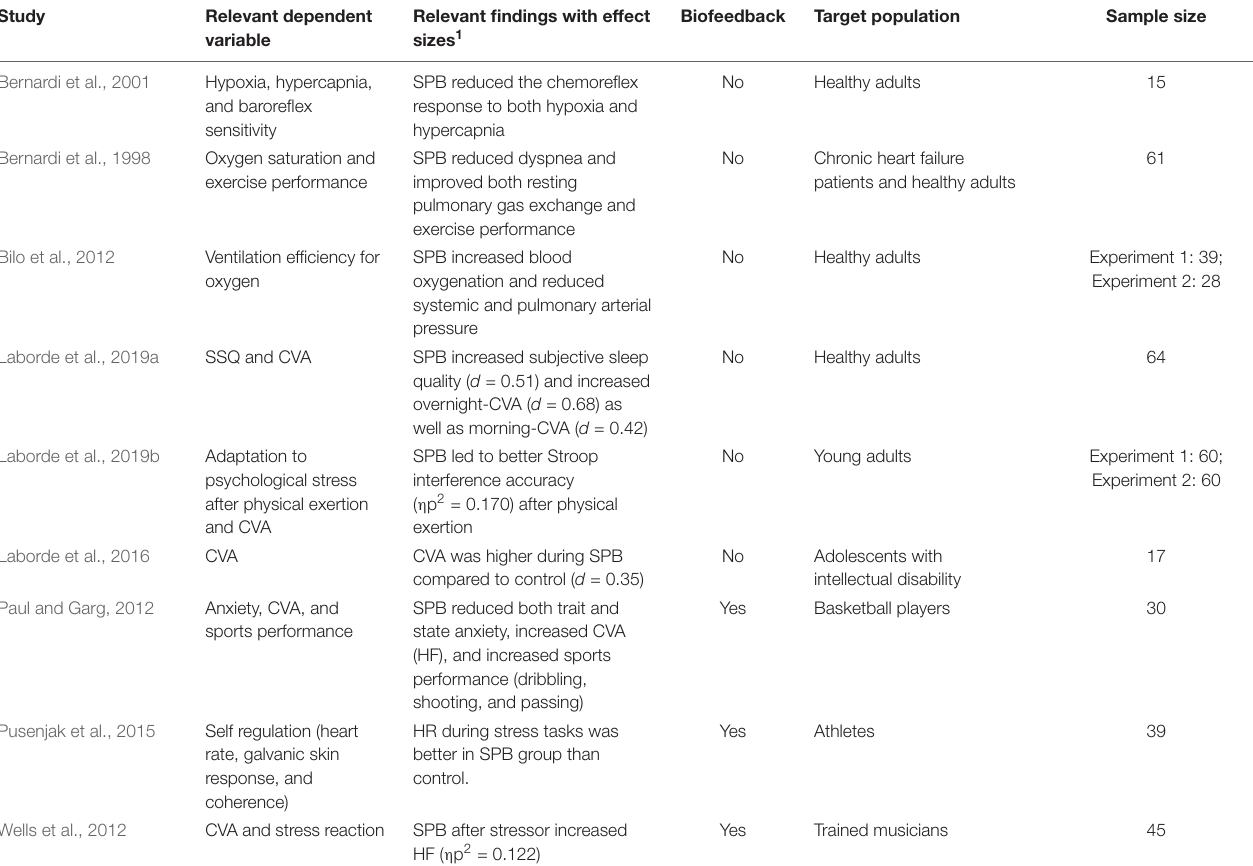
TABLE 1 | Summary of studies with slow-paced breathing that target variables that are relevant in the context of the COVID-19